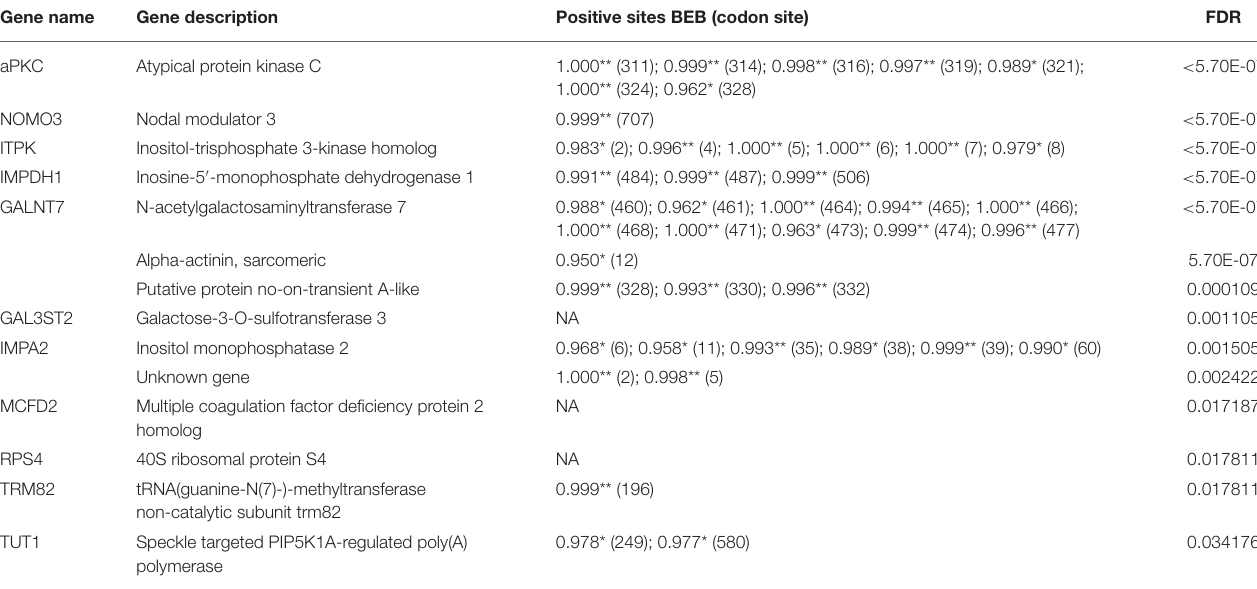
TABLE 2 | A total of 14 PSGs in the supergiant amphipod A. gigantea was identified by a branch-site model in the CodeML